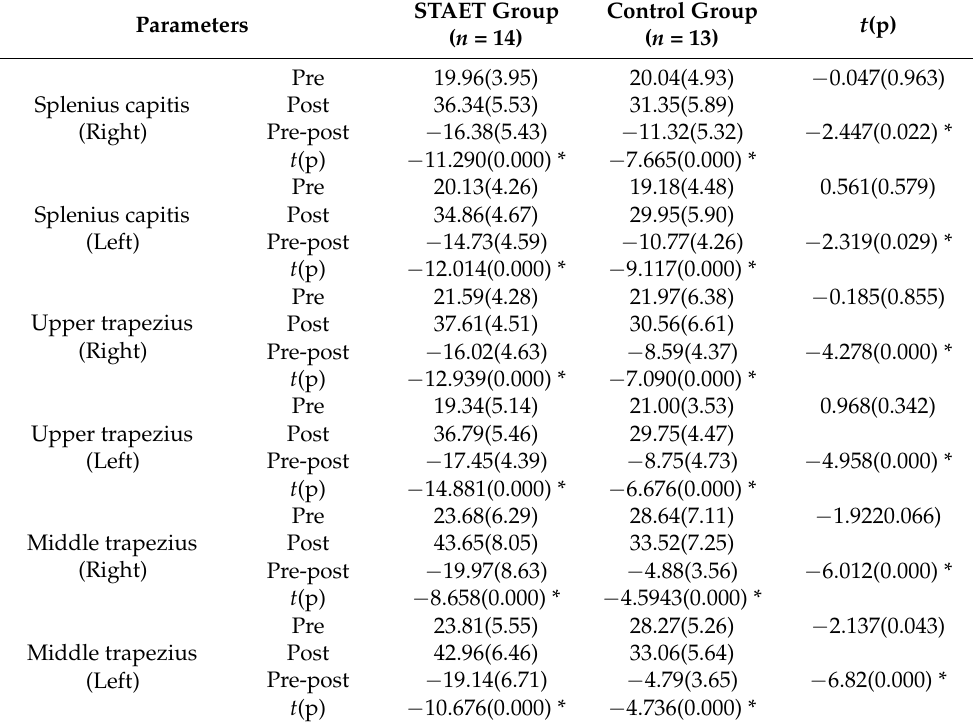
Table 4. Comparison of pressure pain threshold (N = 27).